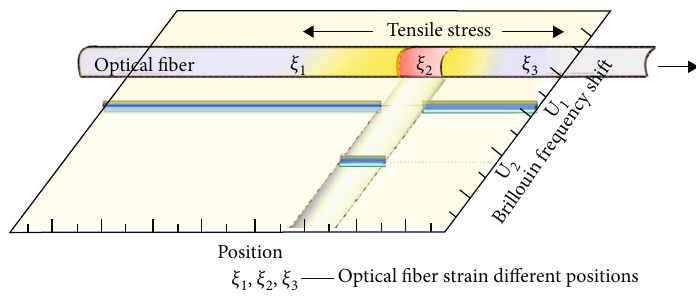
Figure 8: Measurement principle of the BOTDR system.